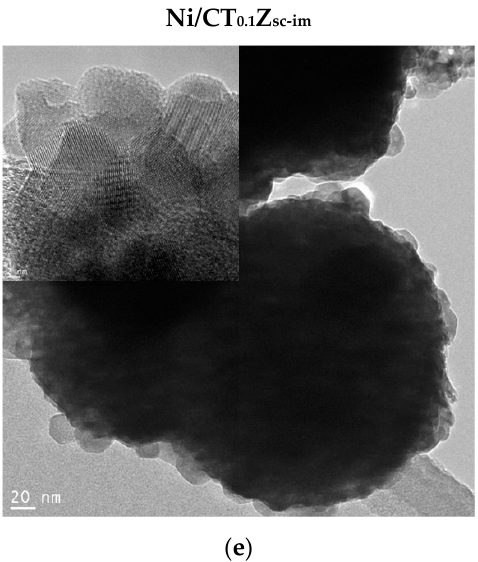
Figure 9. TEM images of impregnated ( a , b ) and one-pot ( c , d ) 5% Ni / Ce 0.75 Zr 0.25 O 2 prepared using the Pechini route ( a , c ) and supercritical synthesis ( b , d ) and Ti-doped catalysts ( e , f ) prepared in supercritical alcohols.